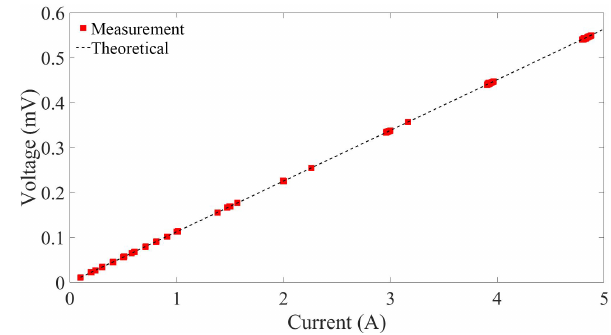
Figure 6. (a) Scatterplot of 1s of samples from two channels recorded with shorted inputs on the preamplifiers; DC offsets are removed. (b) Normalized PDF histogram of channel 1 noise ampli- tudes. The width of the bins is 10nV, and there are 100 bins in total. The red dashed line is the PDF curve of the Gaussian distribution with zero mean and a standard deviation of 114nV.